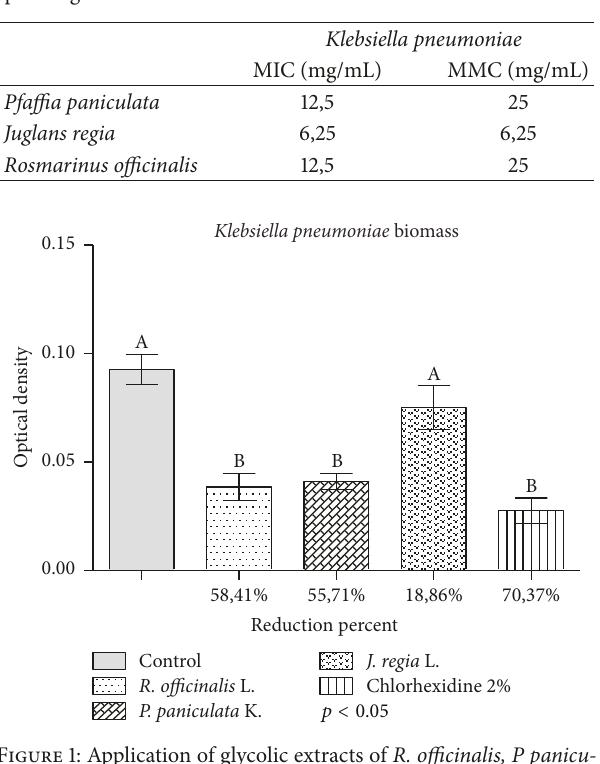
Figure 1: Application of glycolic extracts of R. officinalis, P panicu- lata, and J. regia at concentration of 200 mg/mL in K. pneumoniae biofilm during 5 minutes. Control group was exposed to 0.9% NaCl during 5 min. The results indicate the mean values in reduction of biomass in percentage compared to the control group of each extract. Letters (A or B) express the comparison of groups in statistical analysis ( 𝑝 < 0.05 ).